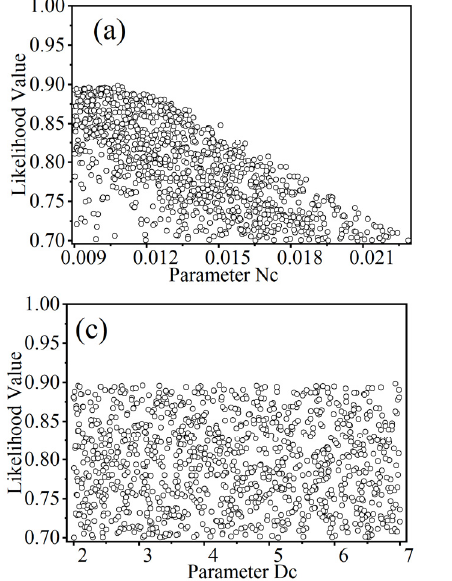
lationship of parameter Ni and NSE; ( c ) Relationship of parameter Dc and NSE. The x -axis represents the posterior distribution of the parameters.